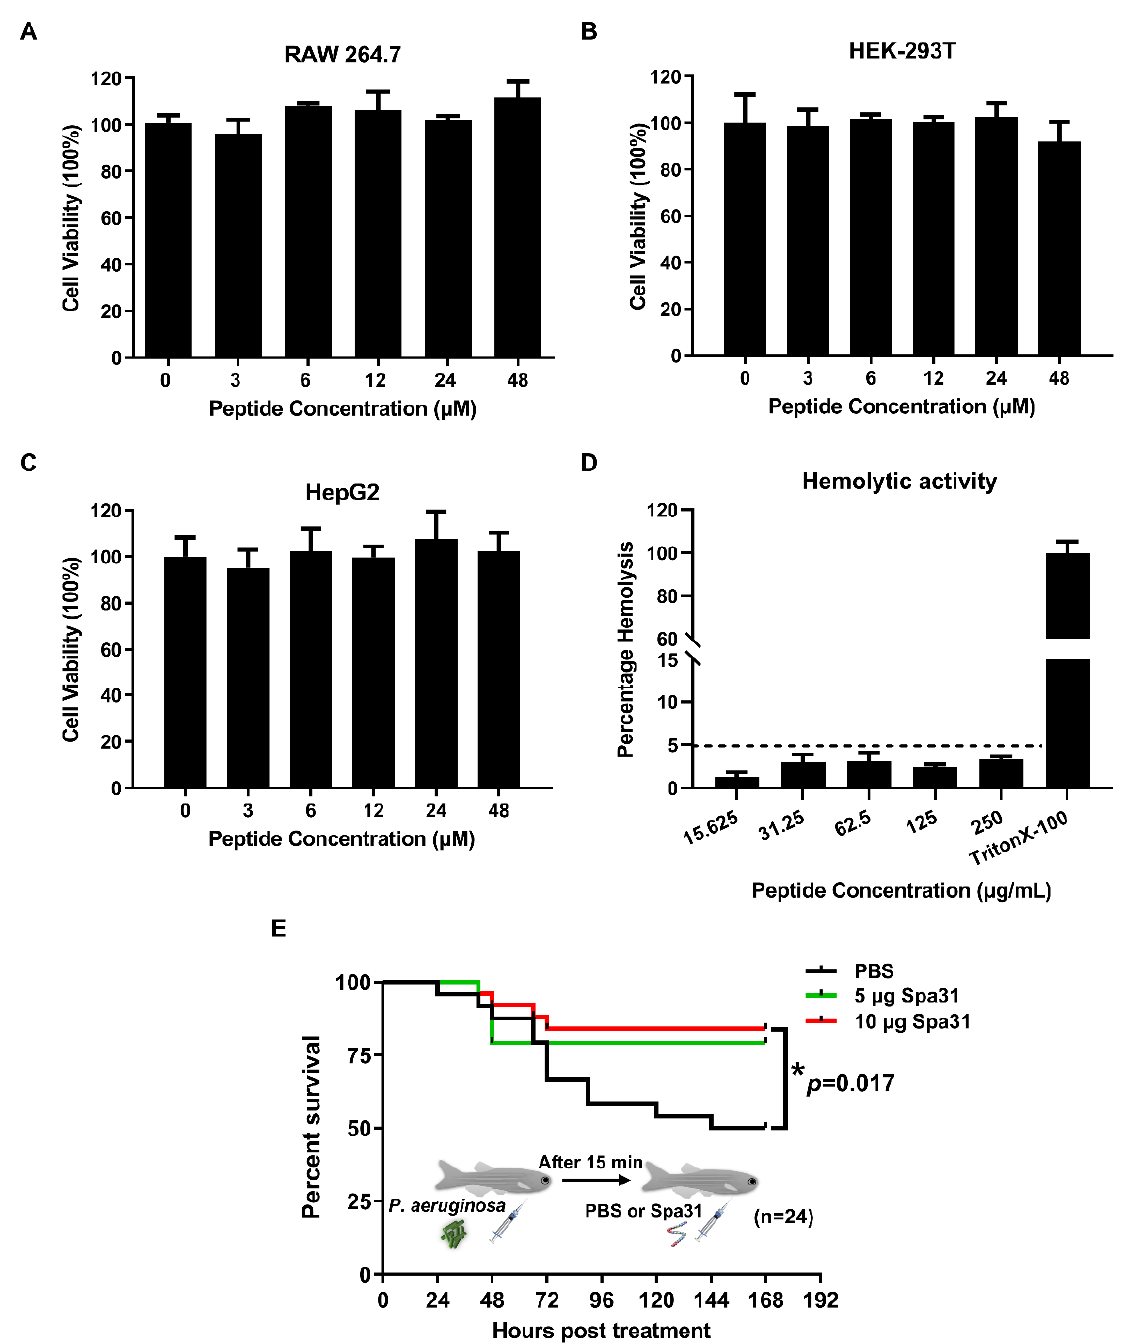
Figure 8. In vitro cytotoxicity and hemolytic activity and in vivo anti- P. aeruginosa infective effect of Spa31. ( A – C ) The effect of Spa31 on cell viability of RAW264.7, HEK-293T, and HepG2 cell lines. ( D ) The hemolytic activity of Spa31 on mouse erythrocytes. TritonX-100 treatment was used as the control. ( E ) The survival curve of P. aeruginosa -infected zebrafish treated with 5 μ g and 10 μ g Spa31.